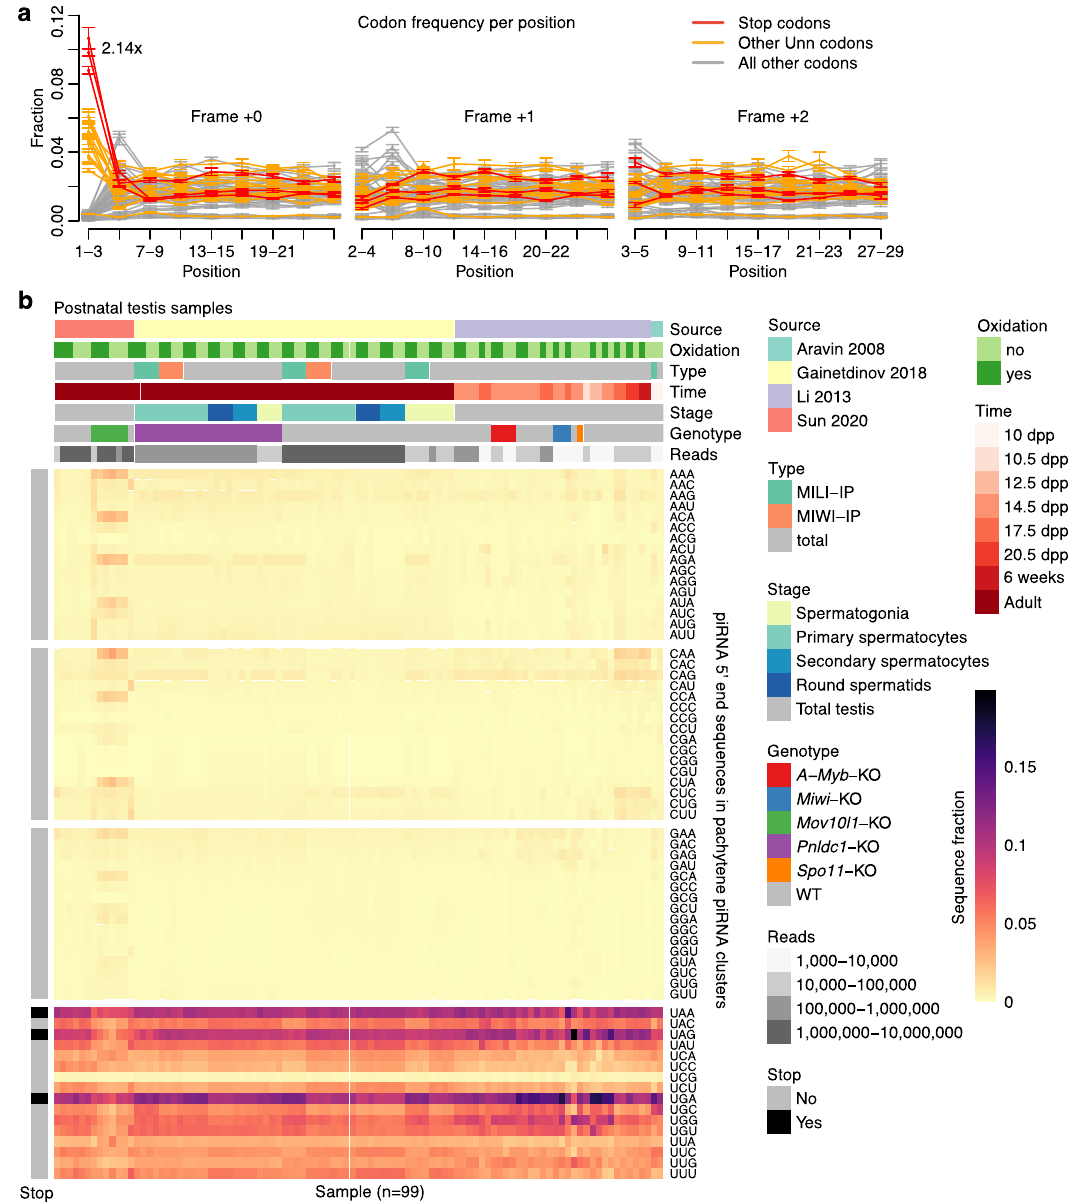
Fig. 1 Postnatal pachytene piRNAs are enriched for stop codons at their 5 ′ ends. a Line graph showing the distribution of codons across piRNAs. Positions are numbered from the piRNA 5 ′ end. Frequency shown as mean ± one standard deviation (sd) (5 replicates). b Heatmap showing 5 ′ end sequence distribution of piRNAs mapping to pachytene piRNA clusters. Rows display relative sequence distribution and columns represent 99 sRNA-seq libraries derived from postnatal mouse testis. Column-wise annotations describe data source publication (Source), whether oxidated RNAs were captured (Oxidation), library type (Type), developmental time point (Time), spermatogenesis stage (Stage), mouse genotype (Genotype), and number of reads (Reads). Row-wise annotations show whether a sequence is a stop codon (Stop). Abbreviations: dpp, days postpartum; KO, knockout; WT, wild-type. See also Supplementary Fig. 1b for all piRNAs. Source data are provided as a Source Data fi